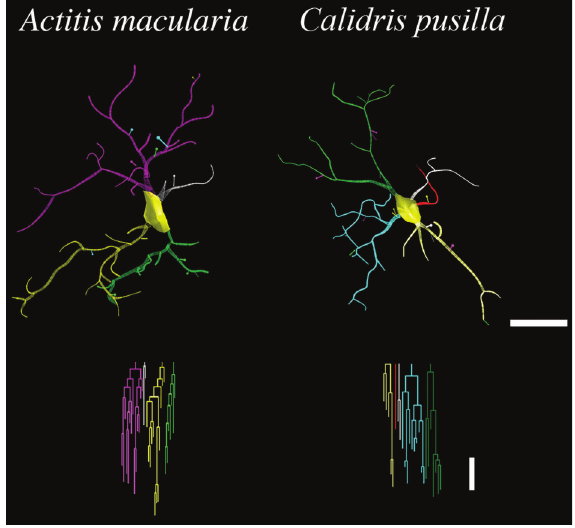
Figure 6. Microglial three-dimensional (3D) reconstructions from sandpiper hippocampus. 3D reconstructions (top) and correspond- ent dendrograms (bottom) of representative microglia showing differences in morphology between sandpipers. Individual branches are distinctly colored to facilitate examination. The linear dendro- grams of microglial arbors show the length of each branch segment displayed to scale; sister branches are horizontally displaced. Branch colors correspond to the 3D reconstructions above. The dendrograms were plotted and analyzed using Neuroexplorer (MBF Bioscience, USA). Dendrograms scale bar=10 m m, 3D reconstruc- tions scale bar=10 m